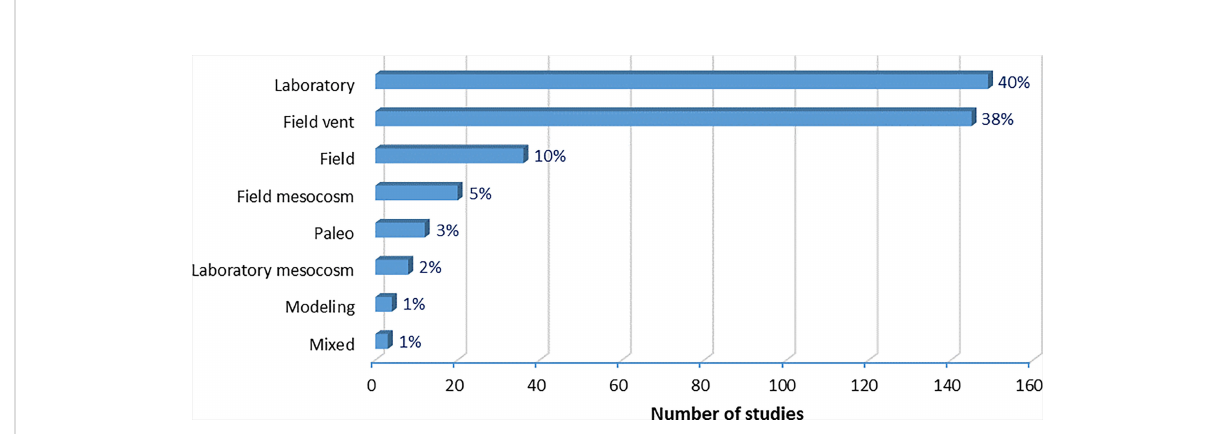
FIGURE 8 Biological study approaches used to derive the biological responses towards